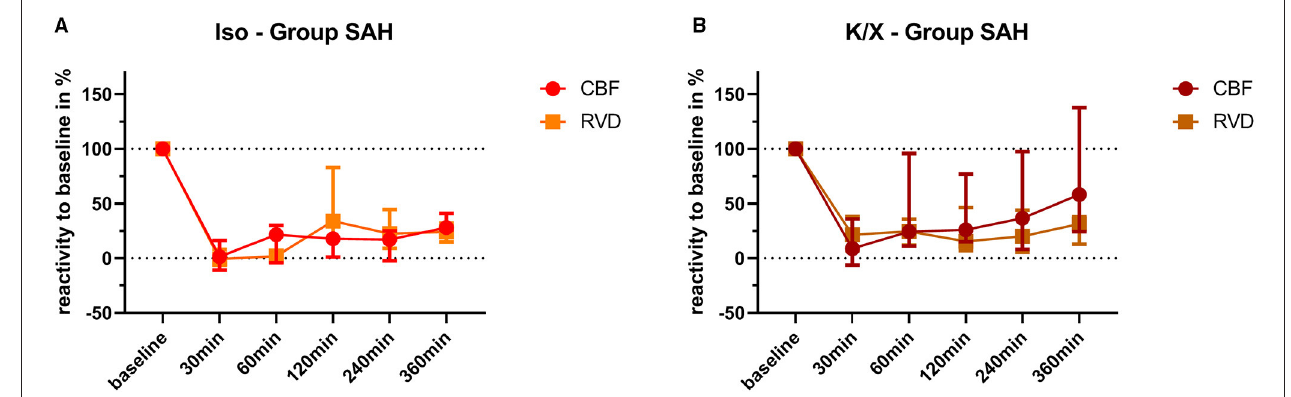
FIGURE 5 | Comparison of vascular reactivity to hypercapnia between retinal and cerebral vasculature. Reactivity at baseline was normalized to 100% for each vascular bed in each animal, and the changes in percentage were calculated over time after SAH. Averaged data of both vascular beds of each group are depicted for comparison. No significant differences were found in the Iso—Group (A) and in the K/X—Group (B) for all time points of hypercapnia challenge. SAH, subarachnoid hemorrhage; Iso, isoflurane; K/X, ketamine/xylazine; CBF, cerebral blood flow; RVD, retinal vessel diameter; symbols show median and whiskers show 25 and 75%